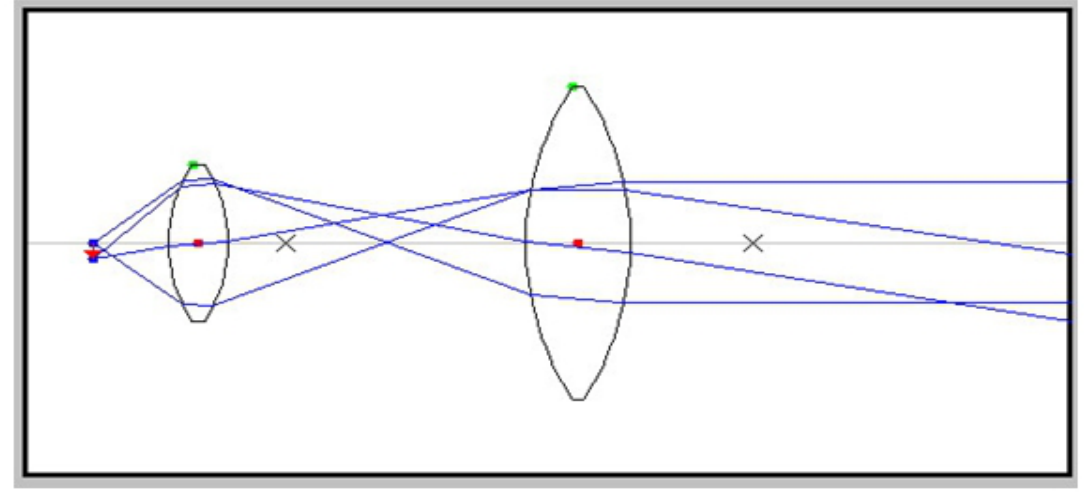
Figure 5. Initial display of applet No. 5,